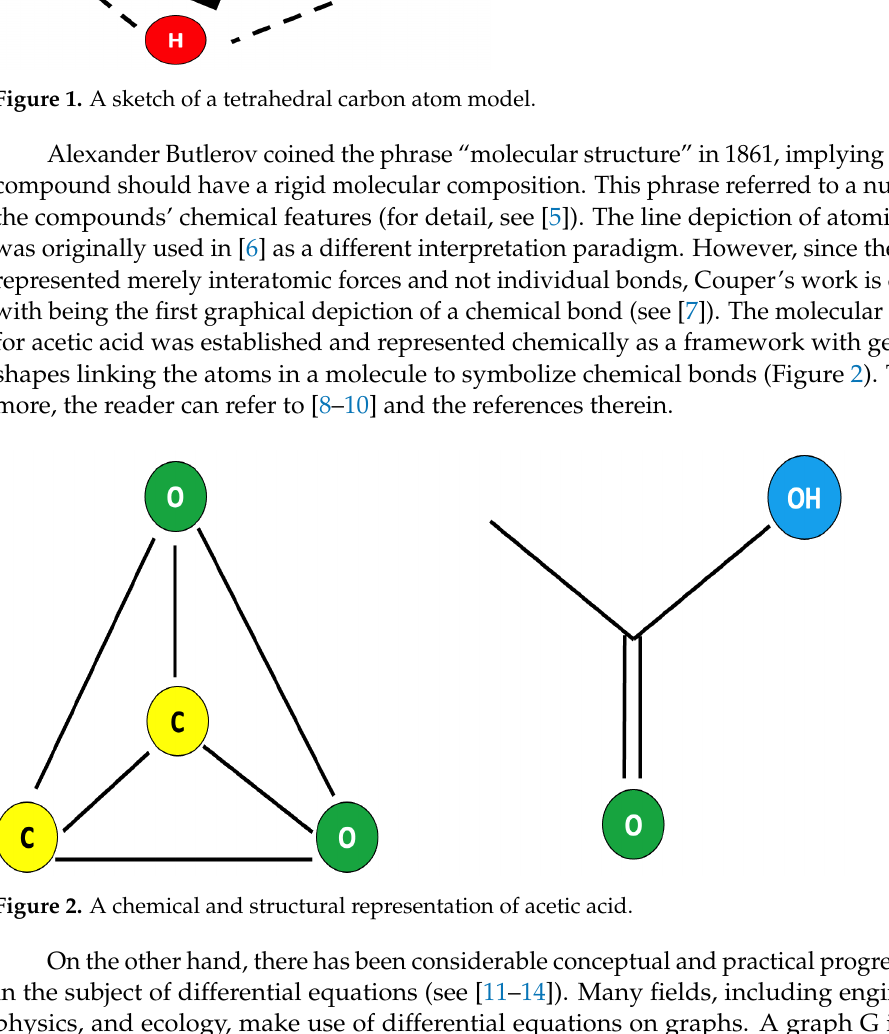
( A ( G ) , B ( G )) consisting of nodes A ( G ) : = { υ (cid:96) : (cid:96) = 0, 1, 2, . . . } and the edges B ( G ) : = = 1, 2, 3, . . . } that link them (see Figure 3), which may be either finite or countably { e ı : ı infinite in dimension. Local coordinates are defined on each edge (of a certain length), with the origin located at a specific